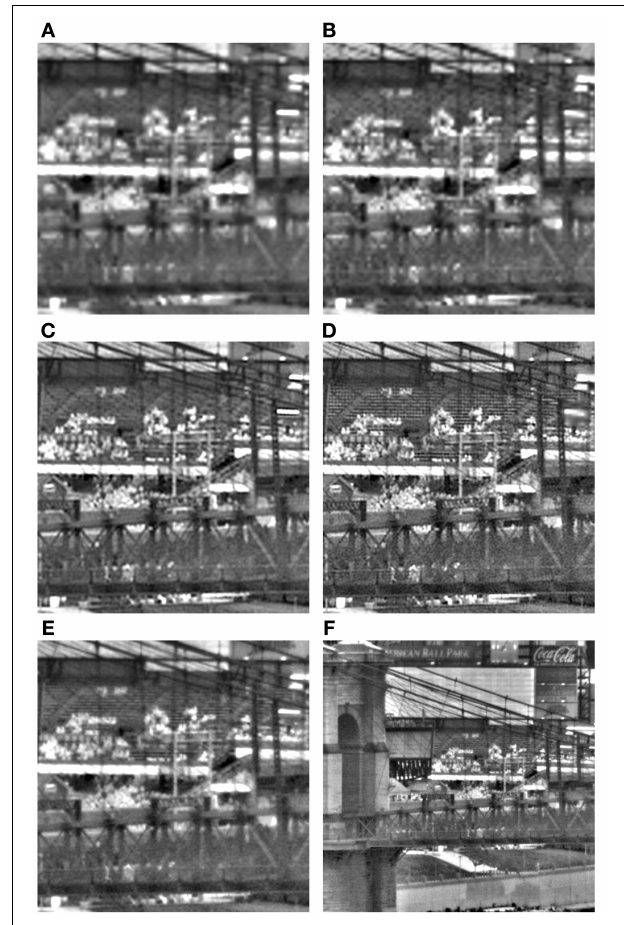
FIGURE 27 | ROI from real MWIR sensor data of resolution chart. (A) L = 3 bicubic interpolation of simulated 100% fill factor detector image at p = 30 μ m; (B) bicubic interpolation of simulated 25% fill factor detector image at p = 30 μ m; (C) K = 16 and L = 3 AWF SR using 100% fill factor detectors; (D) K = 16 and L = 3 AWF SR using 25% fill factor detectors; (E) native sensor image with p = 15 μ m; (F) larger native sensor ROI.